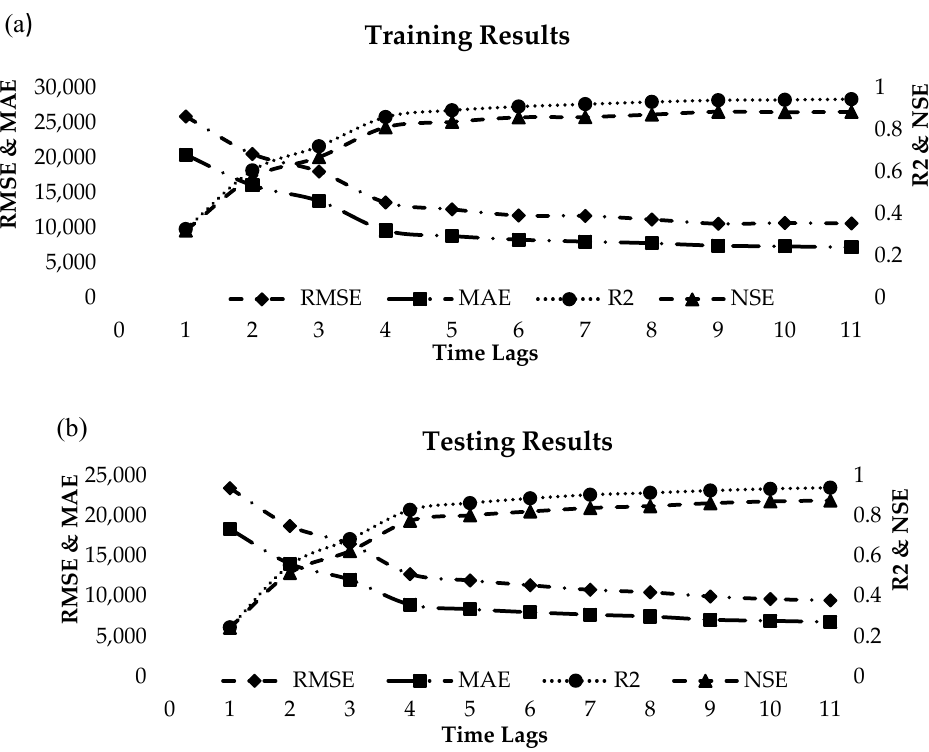
Figure 8. ( a ) and ( b ) Impact of input combinations on the performance. Figure 8. ( a , b ) Impact of input combinations on the performance. The flow duration curves (FDC) in Figure 9 were developed to test the efficacy of developed models in projecting low, medium, and high flows. Figure 9a–d are FDCs generated with various combinations of precipitation and lag precipitation series, such as 1-day precipitation, lag-3-day precipitation, lag-5-day precipitation, lag-8-day precipitation, and lag-10-day precipitation, respectively. The flows on these FDCs can be classed as low, medium, or high. If the flow range with exceedance probability is between 0 and 10, the flow is classified as high. If it is from 11 to 89, the flow is classified as medium, which further separates into two classes: low-medium if the flow ranges from 11 to 49, and high-medium if the flow runs between 50 and 89. The discharge is below the 50th percentile when it exceeds 89 [15]. It can be shown from Figure 9a that DTFs and MLP both underestimate the observed discharge for all three high, medium, and low flows. Figure 9b illustrates that MLP and DTFs tie for high and high medium flow with observed discharge. Figure 9c represents DTFs and MLP, which are comparable for high and medium flow. MLP underestimates the observed discharge in the region of low flow and low, medium flow. Figure 9d shows that DTFs capture the high, medium, and low flow with observed discharge better than MLP, and the last Figure 9e directs the best relationship with observed discharge for DTFs, including high, medium, and low